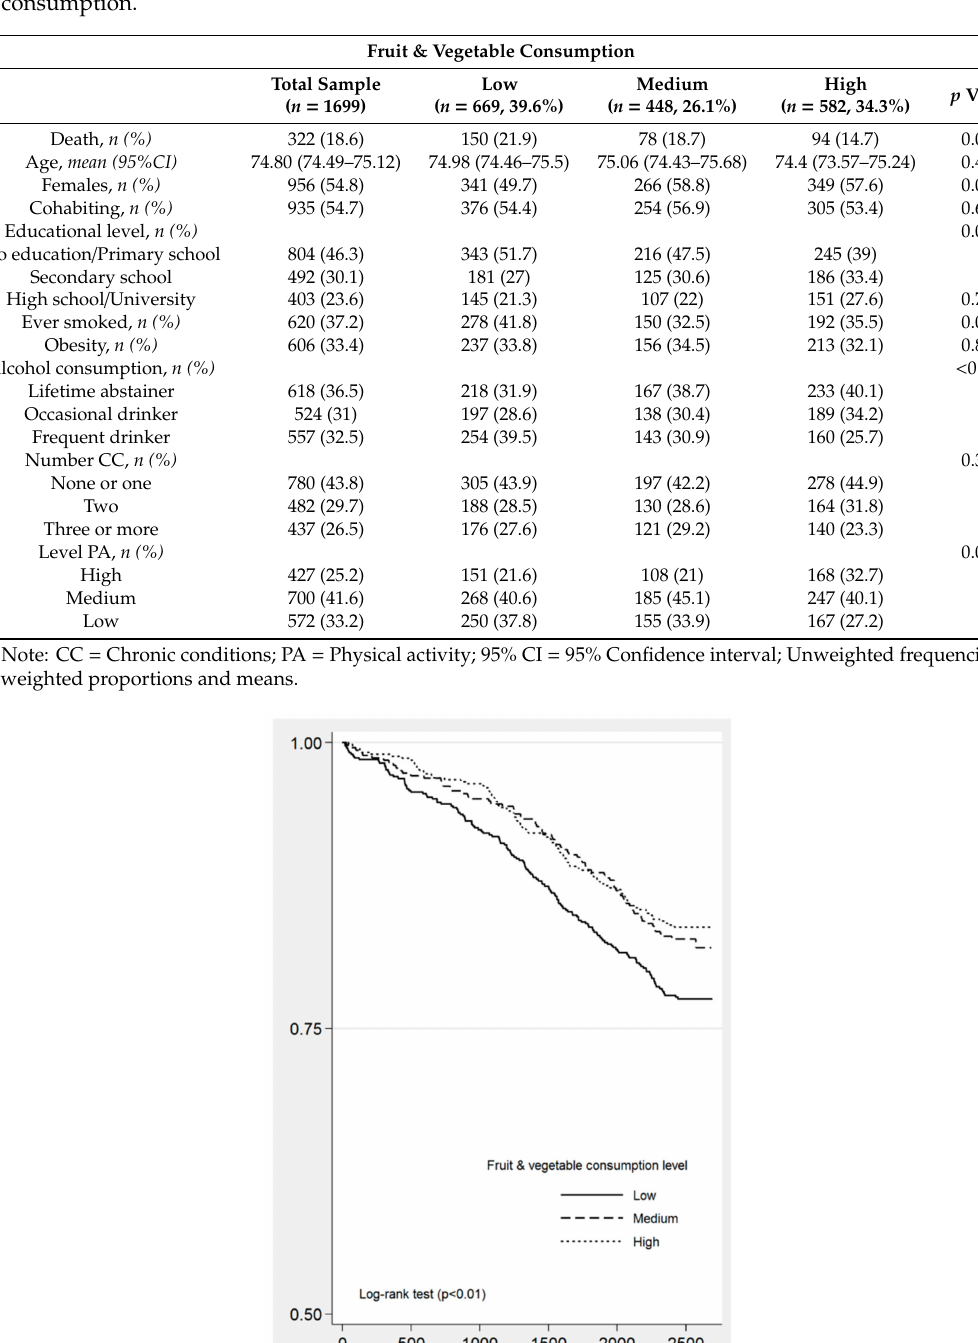
Table 1. Baseline characteristics of the sample and comparison between levels of fruit and vegetable consumption.